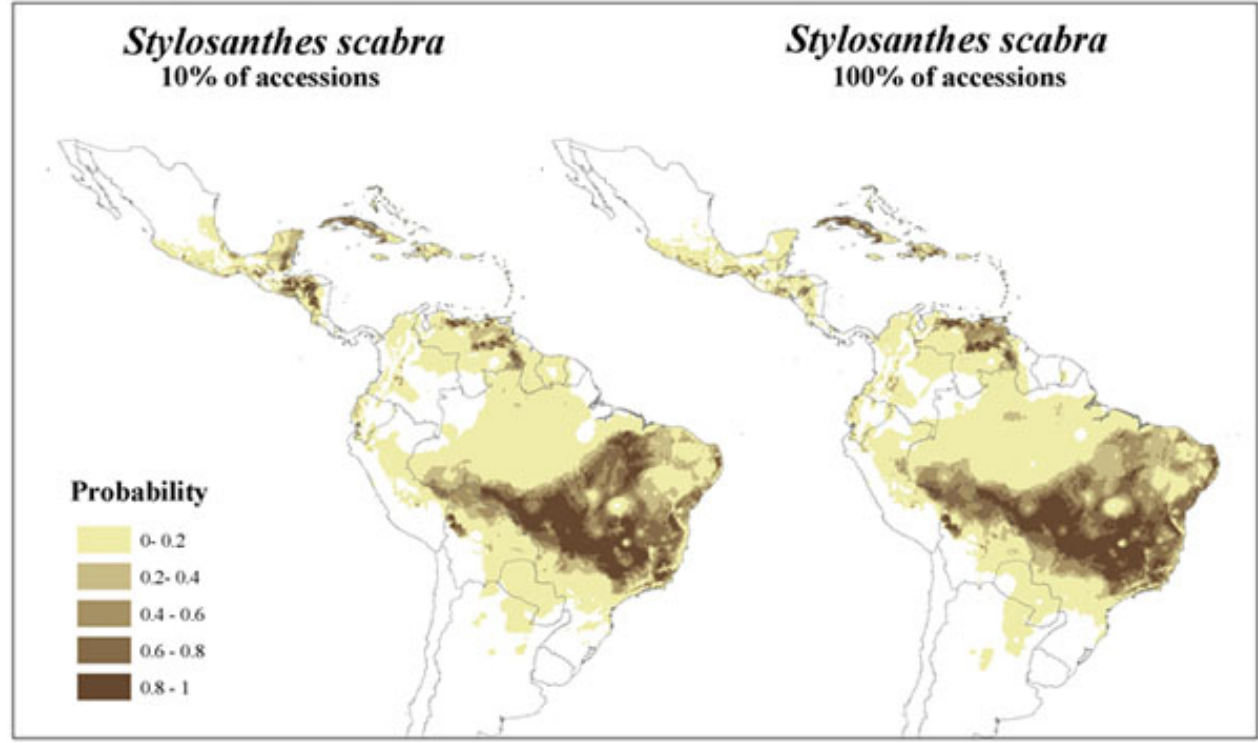
Fig. 2 . Probability distribution of Stylosanthes scabra with the sample divided into random selections of 10% and 100% of the